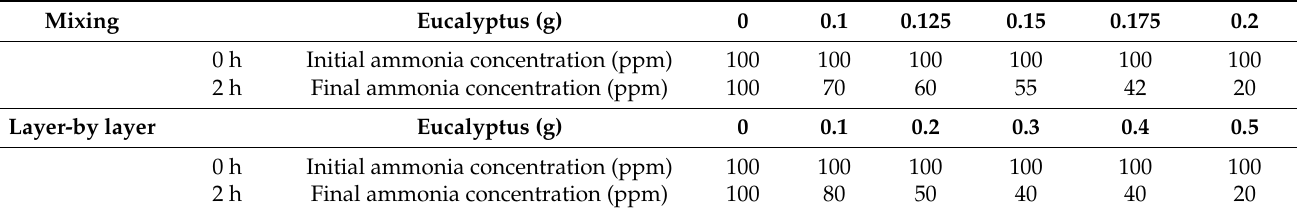
Table 1. Evolution of the concentration ammonia in ppm after exposition to eucalyptus-based